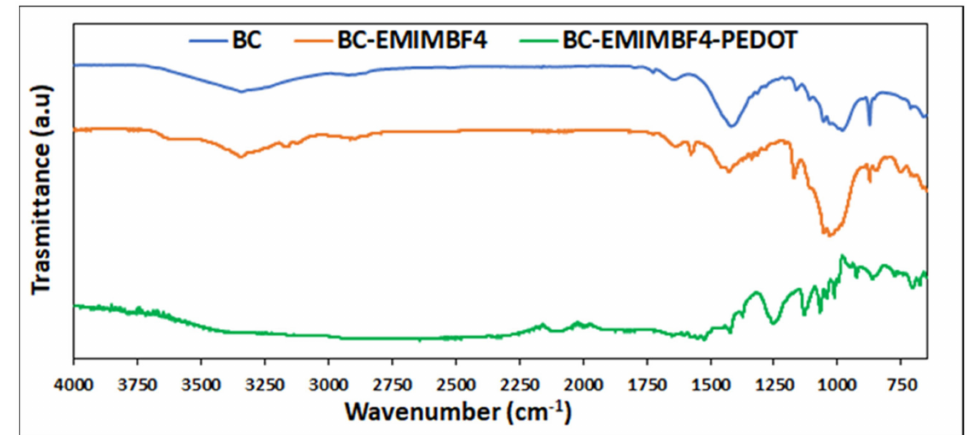
Figure 4. FTIR ATR spectra of BC, BC-EMIMBF4, and